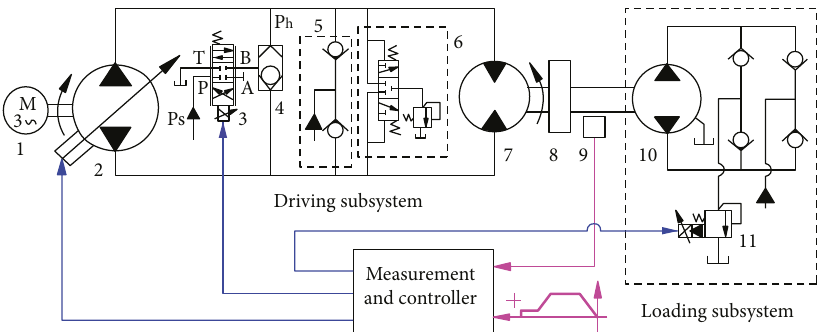
Figure 5: Schematic framework of the experimental system. 1: electric motor; 2: fi xed displacement pump; 3: PDV; 5: shuttle valve;